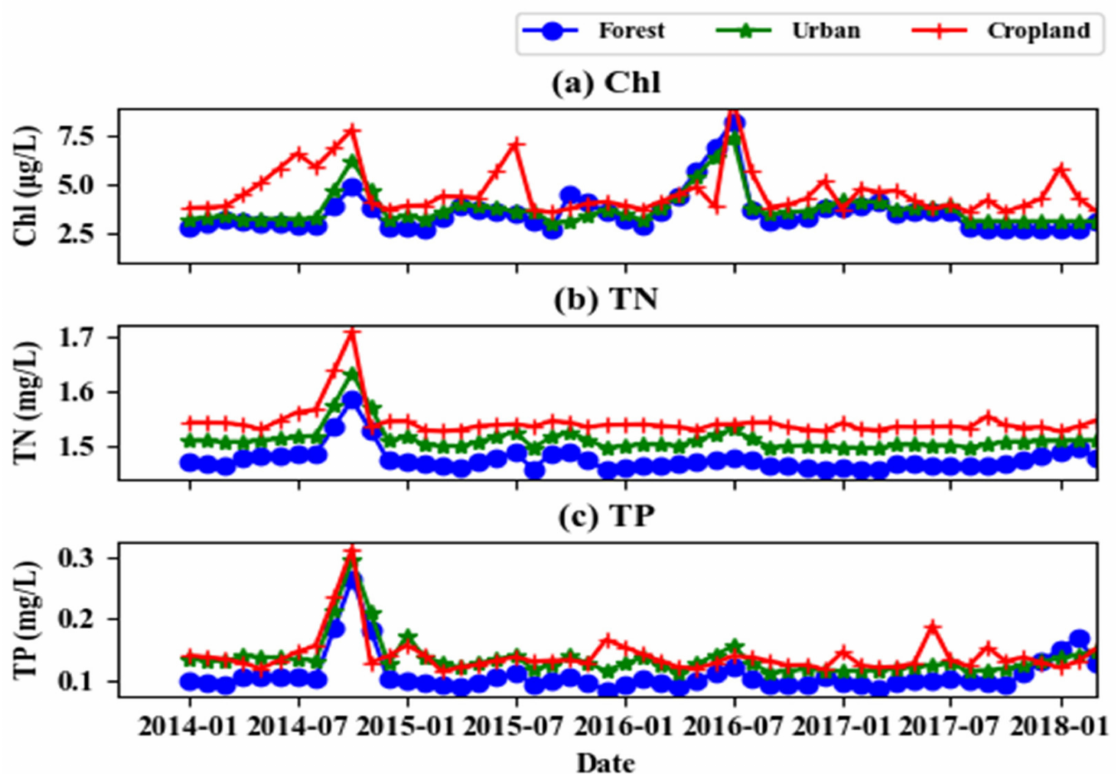
Figure 10. Comparison of ( a ) Chl-a, ( b ) TN, and ( c ) TP concentration under different land use along the coast.